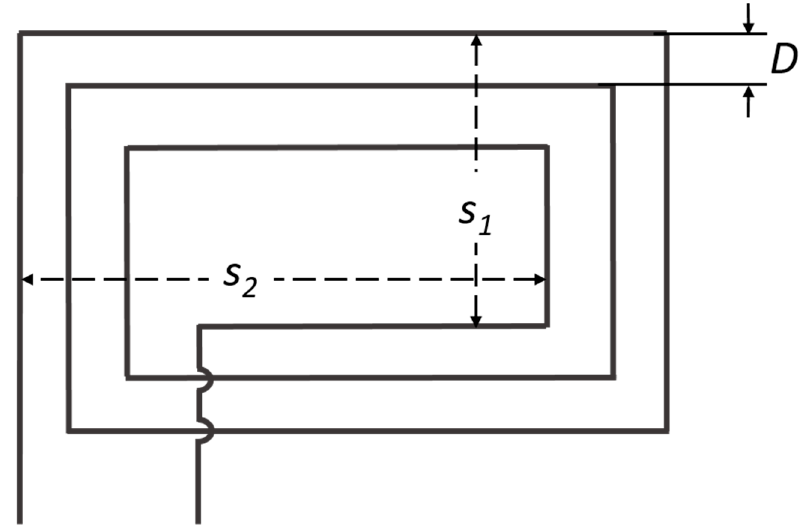
Figure 4. Flat rectangle coil geometry presented by Terman. Adapted from [18].